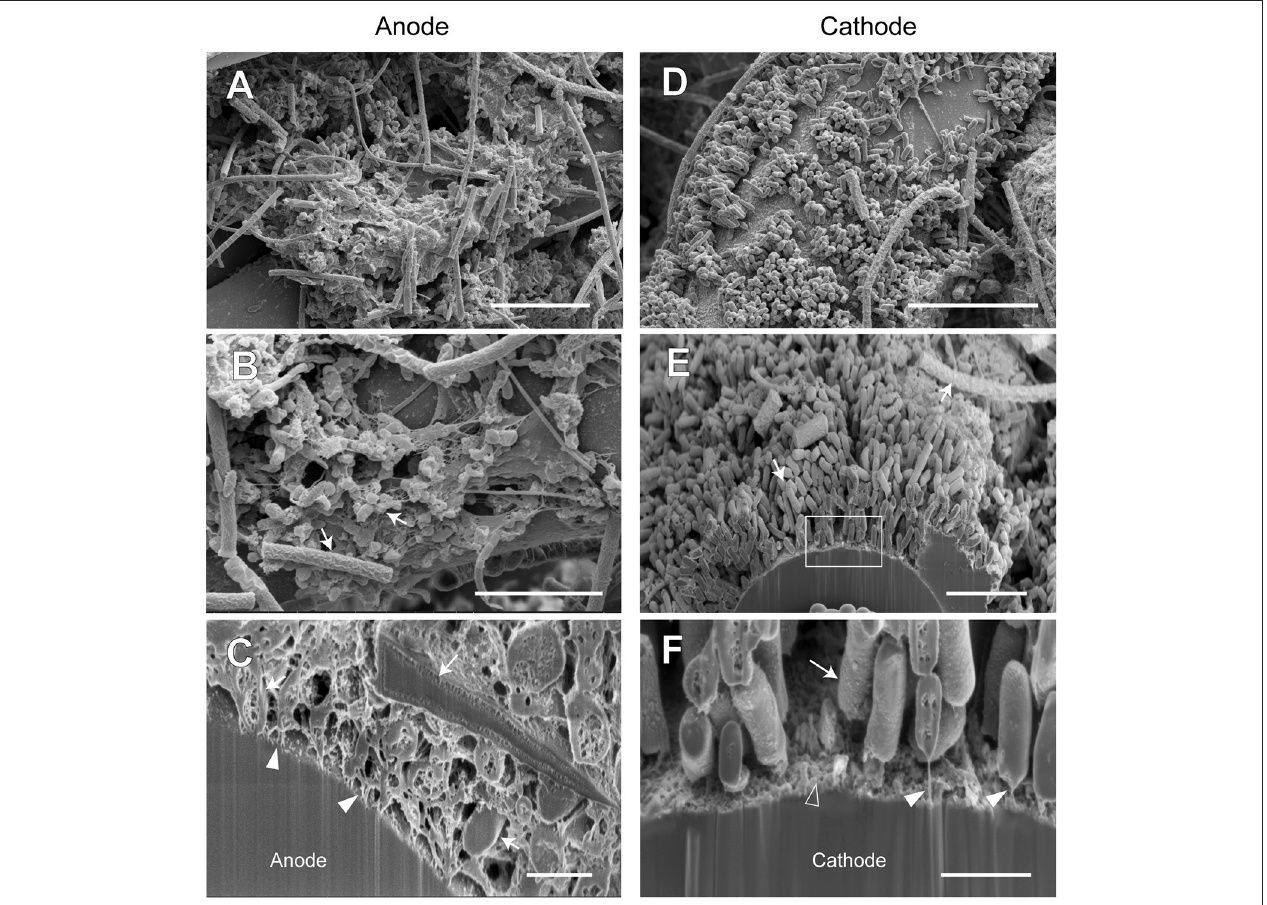
FIGURE 10 | FE-SEM images for anode and cathode biofilms adhering onto carbon cloth electrodes in the electromethanogenic BES reactor B. Anode (A–C) and cathode (D–F) samples were collected from BES reactor B after 19-month enrichment process. B,E,F are cross-section images of biofilms that were processed by a focused ion beam, and (F) shows a magnified image near electrode [rectangle region in (E) ]. Arrows in B,C,E,F indicate microbes close to the electrodes. Filled arrowheads in (C,F) indicate filamentous structures in the anode biofilm, while open arrowhead in (F) indicates heterogeneous deposit on the cathode surface. Bars (A, D) = 10 µ m. Bars (B, E) = 5 µ m. Bars (C, F) = 1 µ